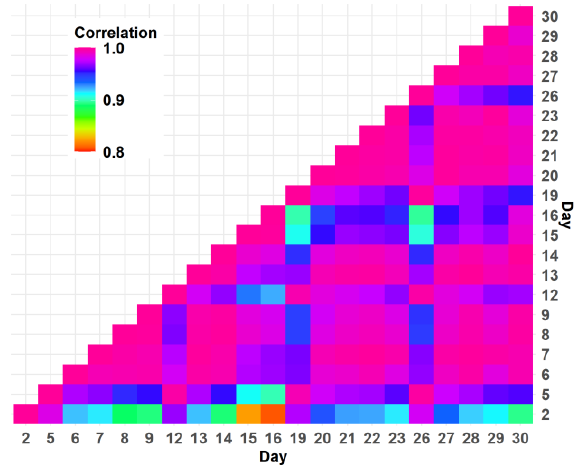
Figure 12. Correlation coefficient of daily heating energy in January (2, 2 January; … ; 30, 30 January).